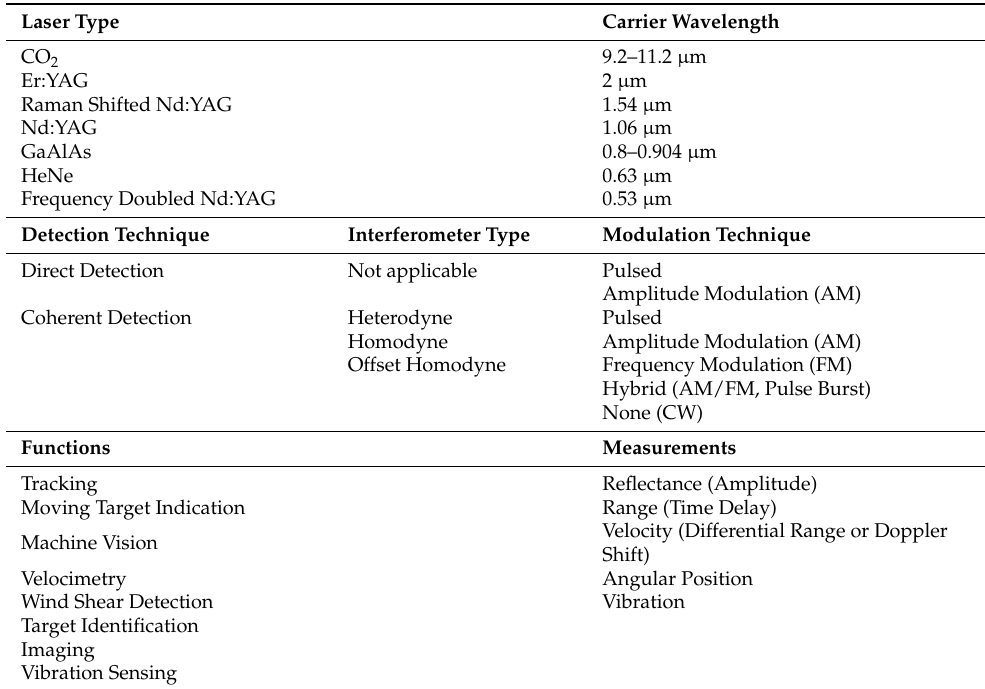
Table 1. Types of LIDAR